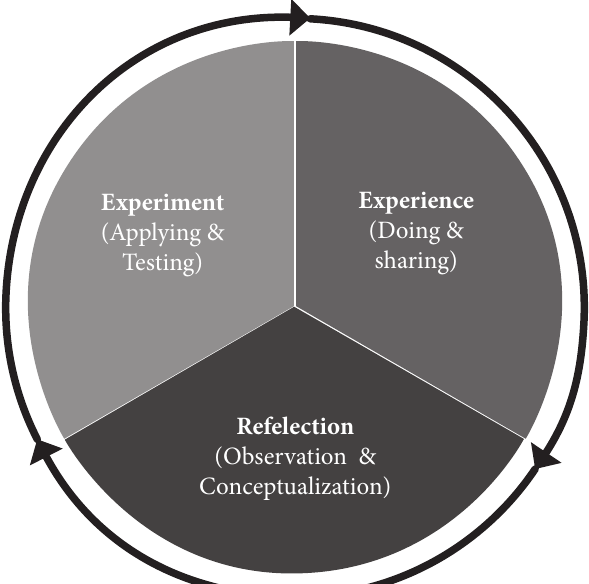
Figure 4: ERE Cycle